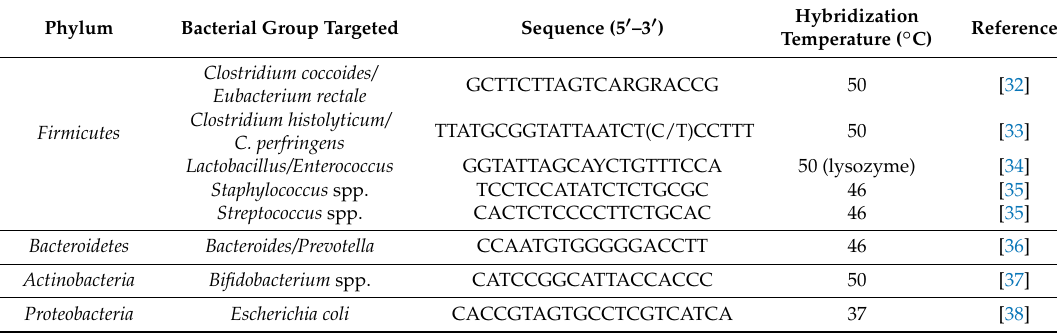
Table 1. Oligonucleotide probes and hybridization conditions used in the analysis of intestinal bacteria by FISH-FCM. Y = (C/T), R =